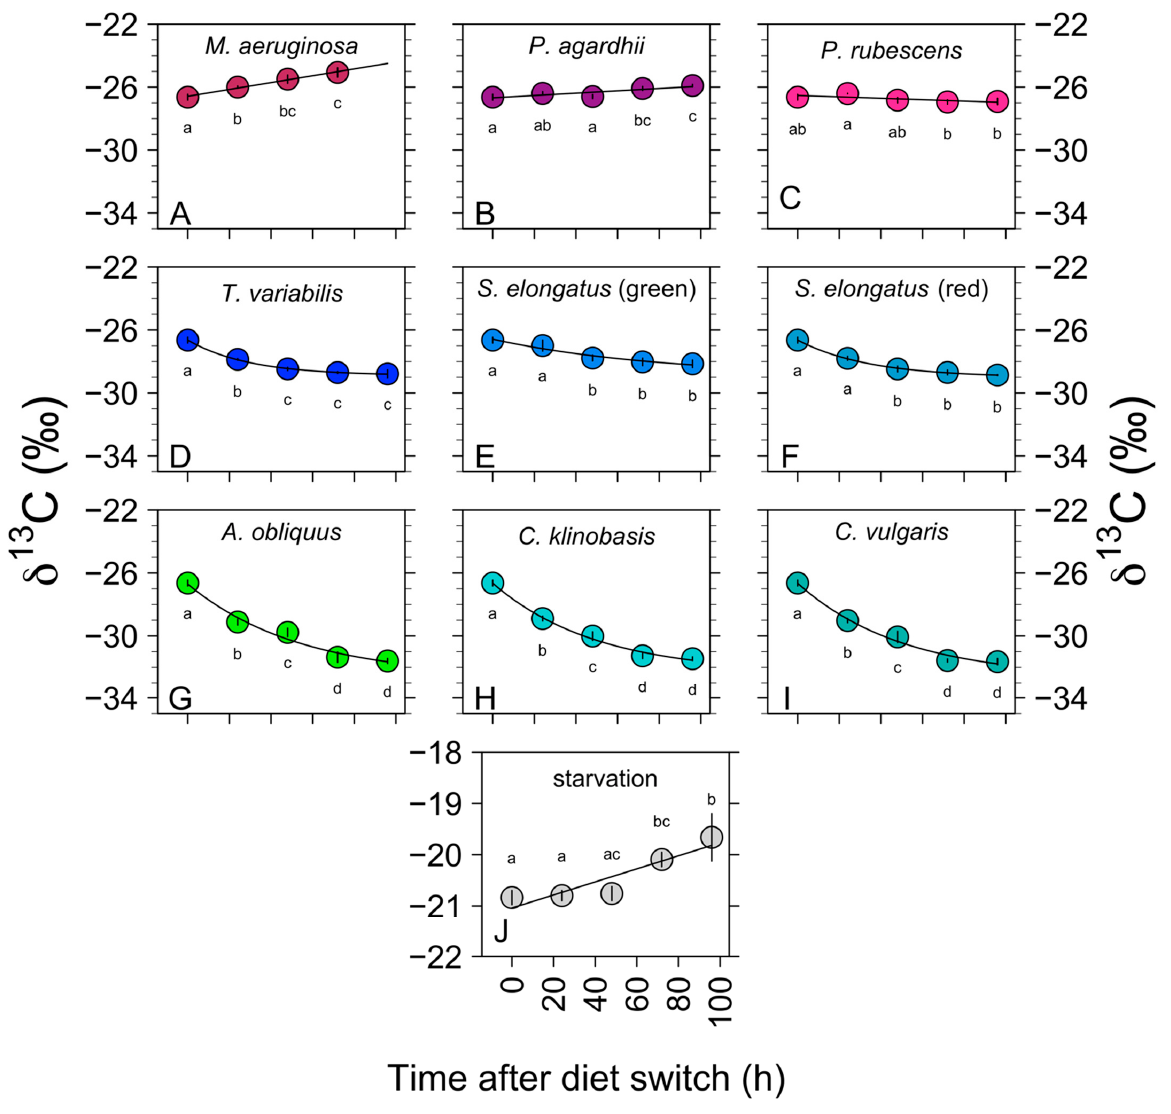
Figure 2. Carbon isotopic change in D. magna tissue shown as a function of time (hours) after changes to isotopically distinct captive diet types (or during starvation). The colored lines represent the signatures of the associated diet while the black lines represent the time-based exponential ( D – I ) or linear ( A – C , J ) model fits. The letters represent statistical differences for the δ 13 C values of the different timepoints.